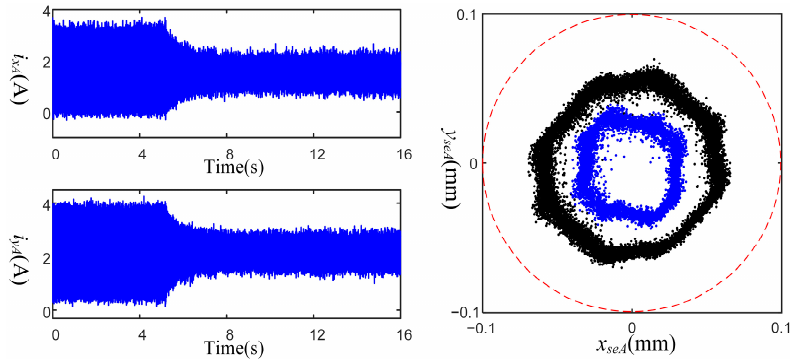
Figure 12. Experimental results of current vibration elimination.